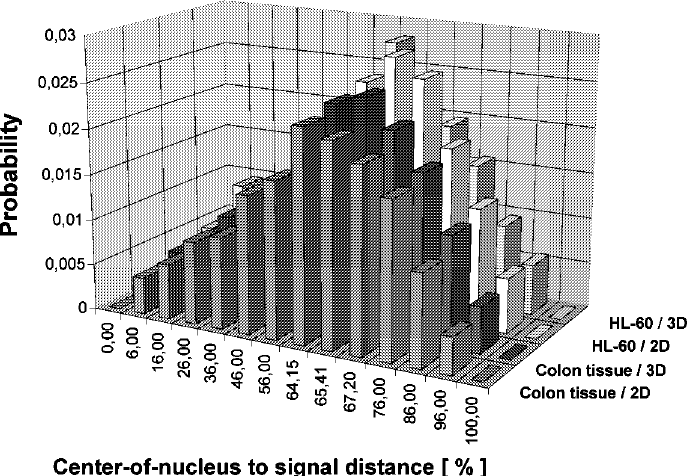
Fig. 2. Comparison of the distributions of the centre-of-nucleus to signal distances determined for the chromosome 7 centromere in 3D fixed, 4 (cid:22) m thick colon tissue sections with those in 2D fixed nuclei of individual cells separated from colon tissue and in HL-60 cells fixed in both 2D and 3D. The number of investigated cells was 200–300 for 3D analysis and 800–1000 for 2D analysis.